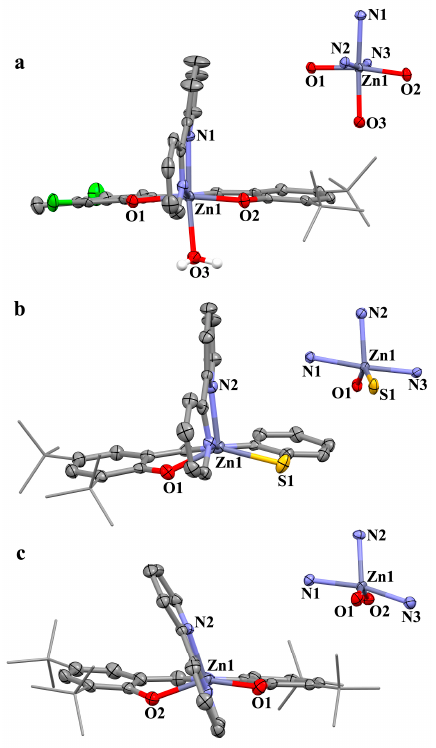
Figure 4. The views on the molecules and inner coordination spheres of 4 · H 2 O ( a ), 6 ( b ), and 8 ( c ) along the bond Zn1–N3. The ellipsoids of 50% probability. The hydrogen atoms are omitted (except for H 2 O in 4 · H 2 O), and the tert-butyl groups are given as capped sticks.